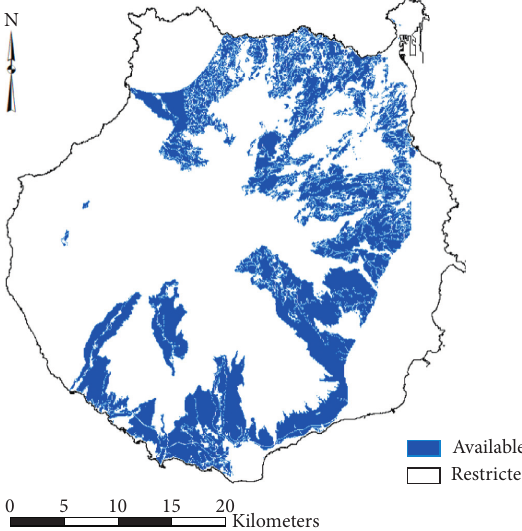
Figure 7: Solar constraint